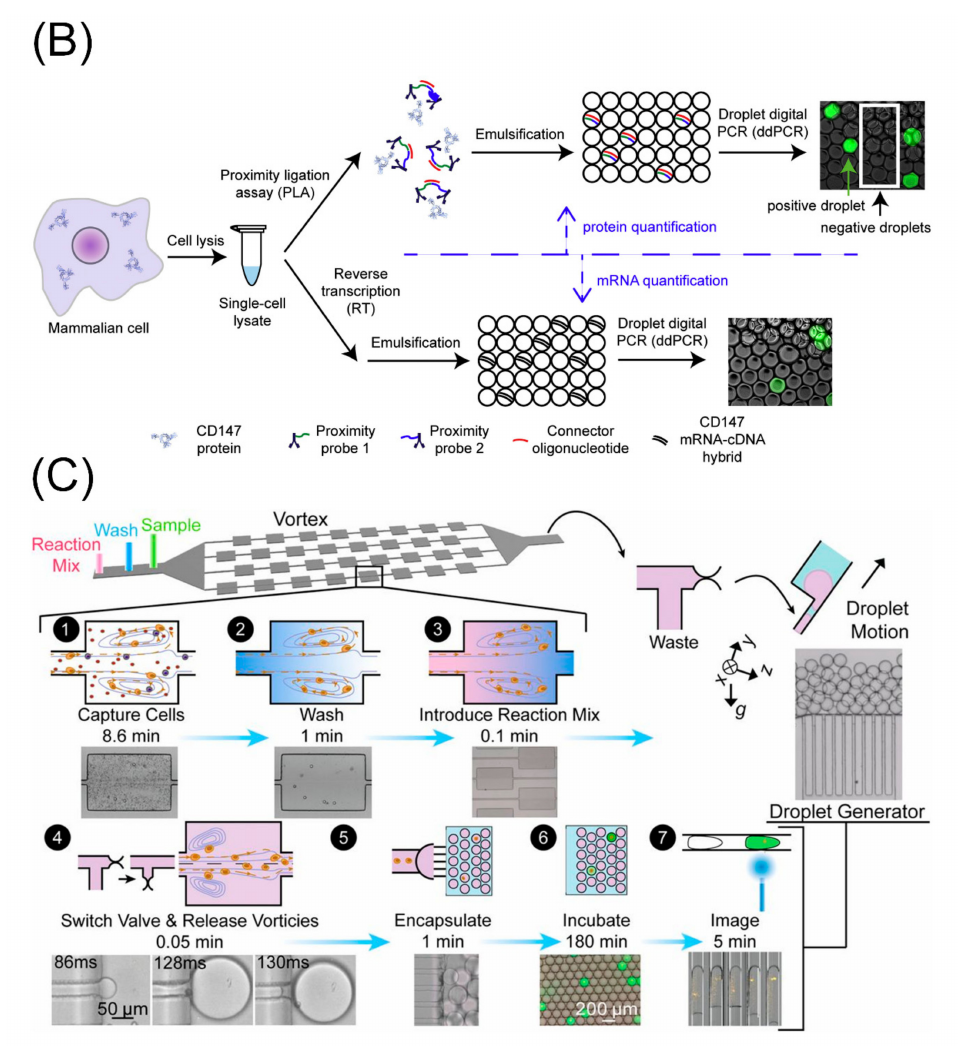
Figure 3. Droplet-based microfluidics for single-cell protein analysis. ( A ) A microfluidic device of picoliter droplets for enzymatic reaction. (a) Single Escherichia coli and substrate 3-O-methylfluorescein-phosphates are encapsulated within single droplets where the substrate is enzymatically hydrolyzed by the target enzyme alkaline phosphatase expressed by E. coli , generating a fluorescent signal; (b) and (c) show the droplet formation that occurred by confluence of three aqueous inlet streams (substrate, bu ff er and cells). Adapted with permission from [77]. ( B ) A new approach for absolute quantification of proteins combining proximity ligation assay and droplet digital PCR. Targeted proteins are isolated, lysed, and converted to dsDNA by standard proximity ligation assay. The dsDNA is distributed among 20,000 droplets at limiting dilution. Single dsDNA molecules in the droplets are then amplified by PCR and counted by measuring the fluorescence using droplet reader based on calibration curve. Adapted with permission from [78]. ( C ) A droplet-based microfluidic system for enzyme secretion from circulating tumor cells (CTCs) based on size purification. The system isolates CTCs by size, exchanges fluid around CTCs to remove contaminants, introduces a matrix metalloprotease substrate, and encapsulates CTCs into microdroplets. The cells can then be incubated and imaged by an imaging cytometer in the droplet generator. Adapted with permission from